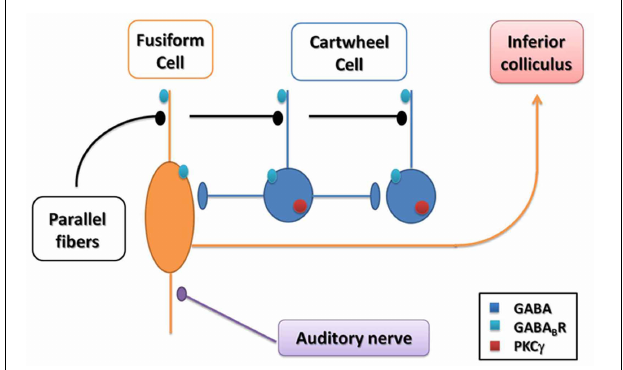
FIGURE 7 | Summary diagram of the circuitry in the DCN. The GABA/GABA B R/PKC γ triple-labeled neurons are distributed in the molecular layer and fusiform cell layer. Most of these neurons are presumed to be cartwheel cells, which receive input from parallel fibers. As inhibitory interneurons, their GABAergic terminals were attached to the other cartwheel cells and fusiform cells. The glutamatergic fusiform cells, which might also express GABA B Rs, receiving inputs from parallel fibers and auditory nerve afferents, finally project to the inferior colliculus (IC). The noise stimulation could activate both cartwheel cells and fusiform cells. The activation of cartwheel cells could be attributed to the decreased GABA B Rs, leading to the disinhibition among the GABA-containing cartwheel cells. The noise injury also increases PKC γ in these activated cartwheel cells. In the glutamatergic fusiform cells expressing GABA B Rs, because of the reduction of GABA B Rs, the loss of presynaptic and postsynaptic inhibition of glutamate activation might promote glutamate neurotransmission in